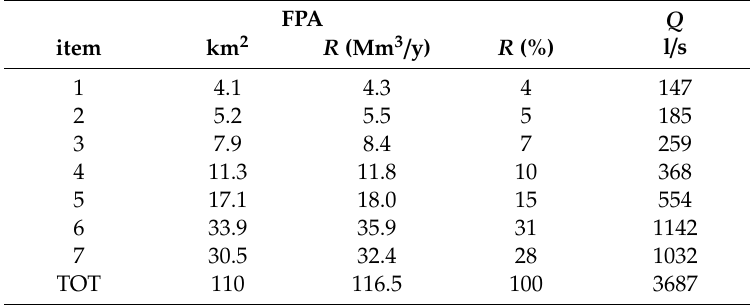
Table 3. The main results obtained from aquifer zoning in flow pipe areas for a thickness of the